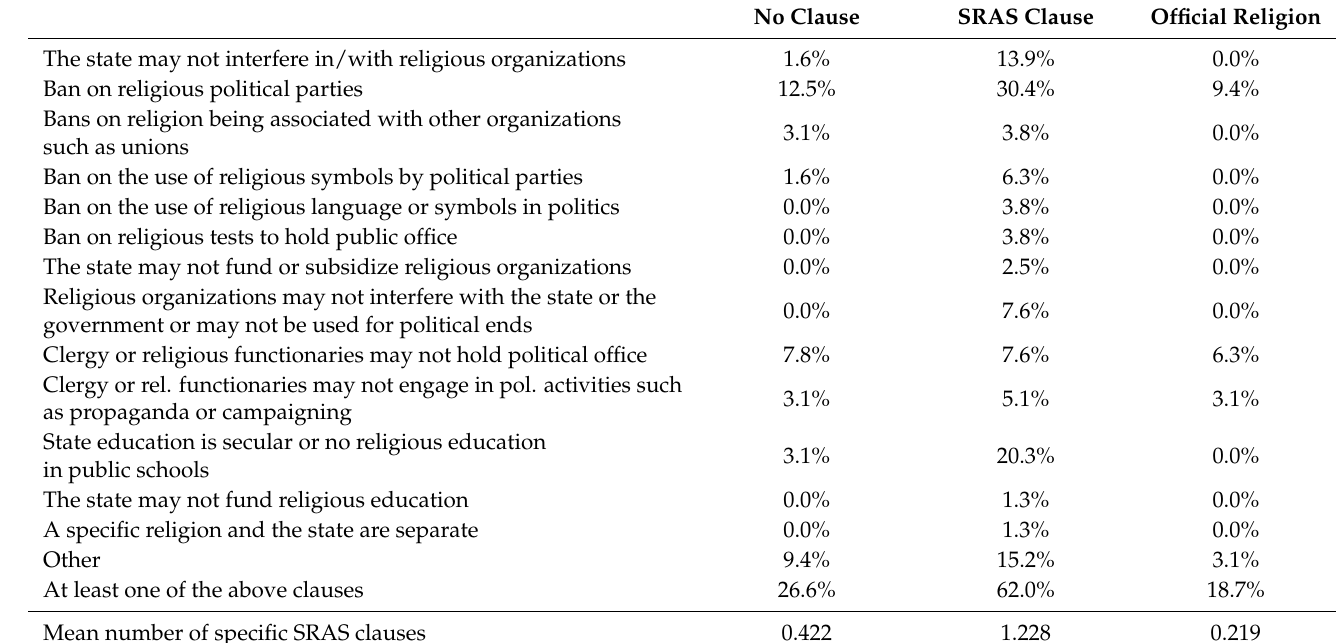
Table 3. Specific SRAS clauses in